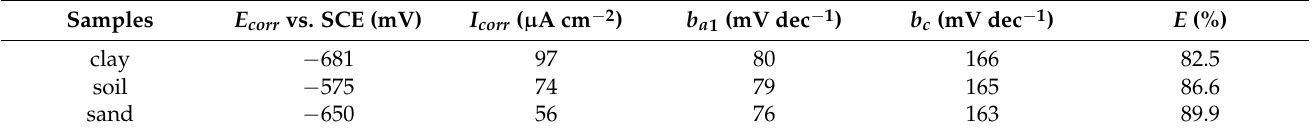
Table 3. Electrochemical parameters and corrosion-inhibiting efficiency of the coated